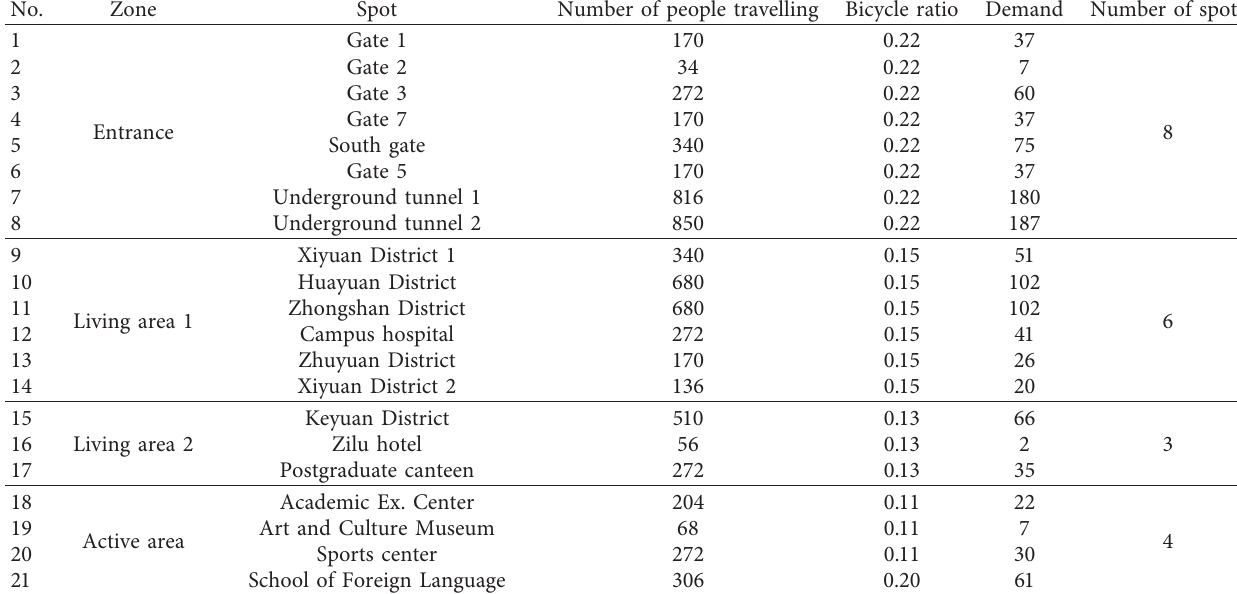
Figure 3: Distribution of alternative parking spots at Nanjing University of Science and Technology. Table 2: Campus zoning